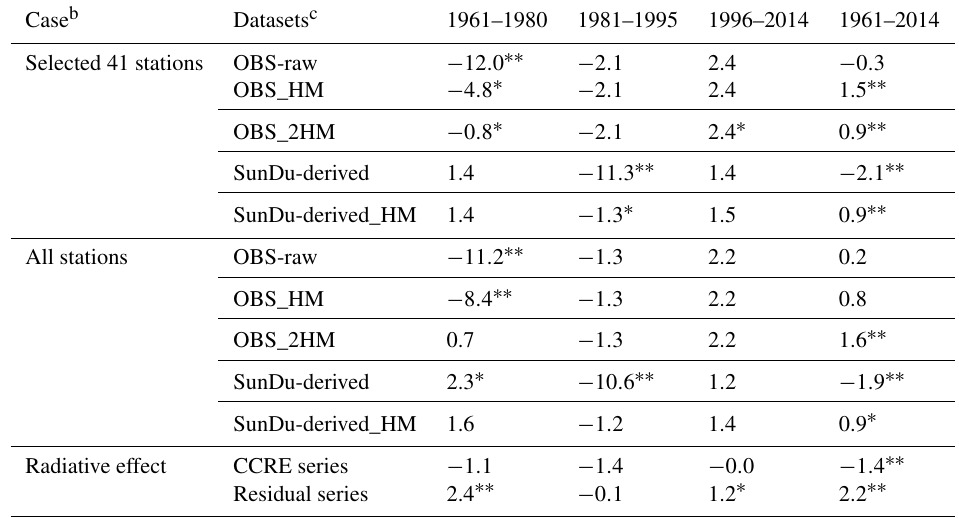
Table 1. Trends of surface incident solar radiation ( R s ) in Japan during specific time periods for different types of datasets a . Unit: Wm − 2 per